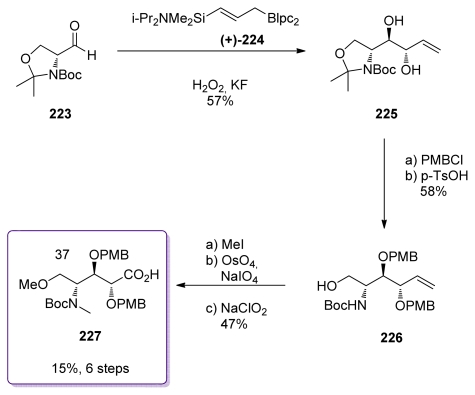
Preparation of 227.